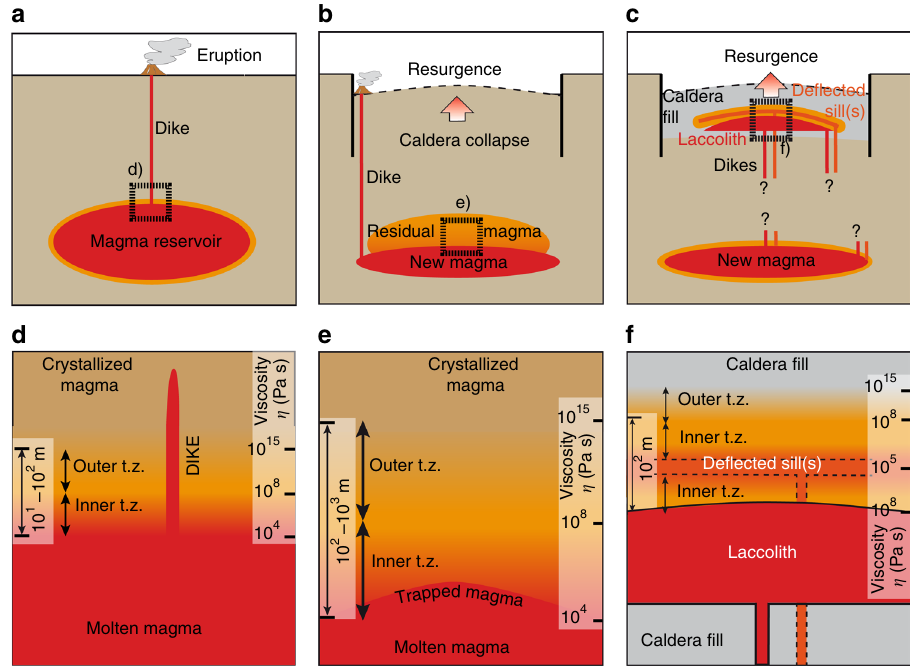
Fig. 5 Model summarising the conditions for the development of a resurgence after caldera collapse. a Conditions developing in a volcano with a thinner transition zone between molten and crystallised magma: dike propagation is promoted and eruptions are more frequent. b A caldera-forming eruption partly empties the magma reservoir, leaving a thicker transition zone; this rheological barrier hinders the propagation of new magma through dikes, promoting stagnation at depth and resurgence at the surface; modest eruptions may occur at the periphery of the system. c Alternatively, or in combination, to b , dikes may arrest at shallower levels, within the physical barrier of the altered intracaldera tuff. Here the arrested dike(s) (orange) may develop one or more sills (orange) within a transition zone (light orange), constituting a barrier for successive dikes (red), stagnating in laccoliths and promoting resurgence; the transition zone related to this latter (red) magma is not shown. The dikes feeding these shallow (orange and red) intrusions may nucleate from the periphery of, and/or within, the magmatic reservoir below, as inferred by the “ ? ” signs. d , e , f illustrate the details of the processes occurring in the dashed boxes in a , b , c , respectively; these detailed boxes are accompanied by probable estimates of the thickness of the transition zone (left) with a given viscosity range